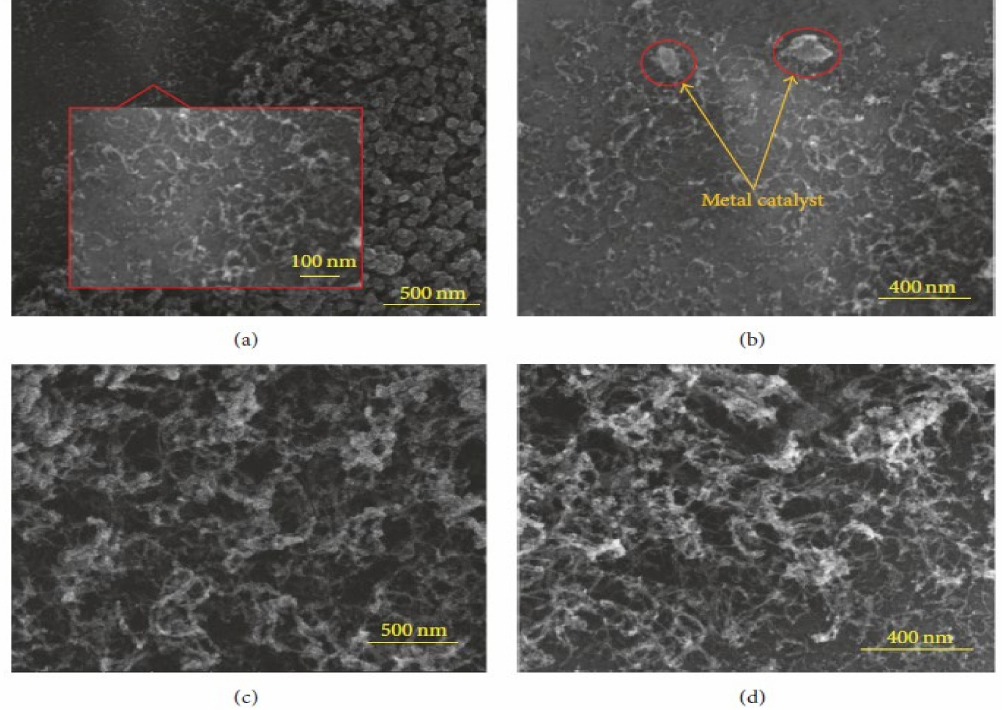
Figure 4. FESEM images of the RH derived CNTs by MO technique for 38 min with ( a ) 500 nm, ( b ) 400 nm (weak interaction between RH and substrate), ( c ) 500 nm, and ( d ) 400 nm. Adapted with permission from Ref.